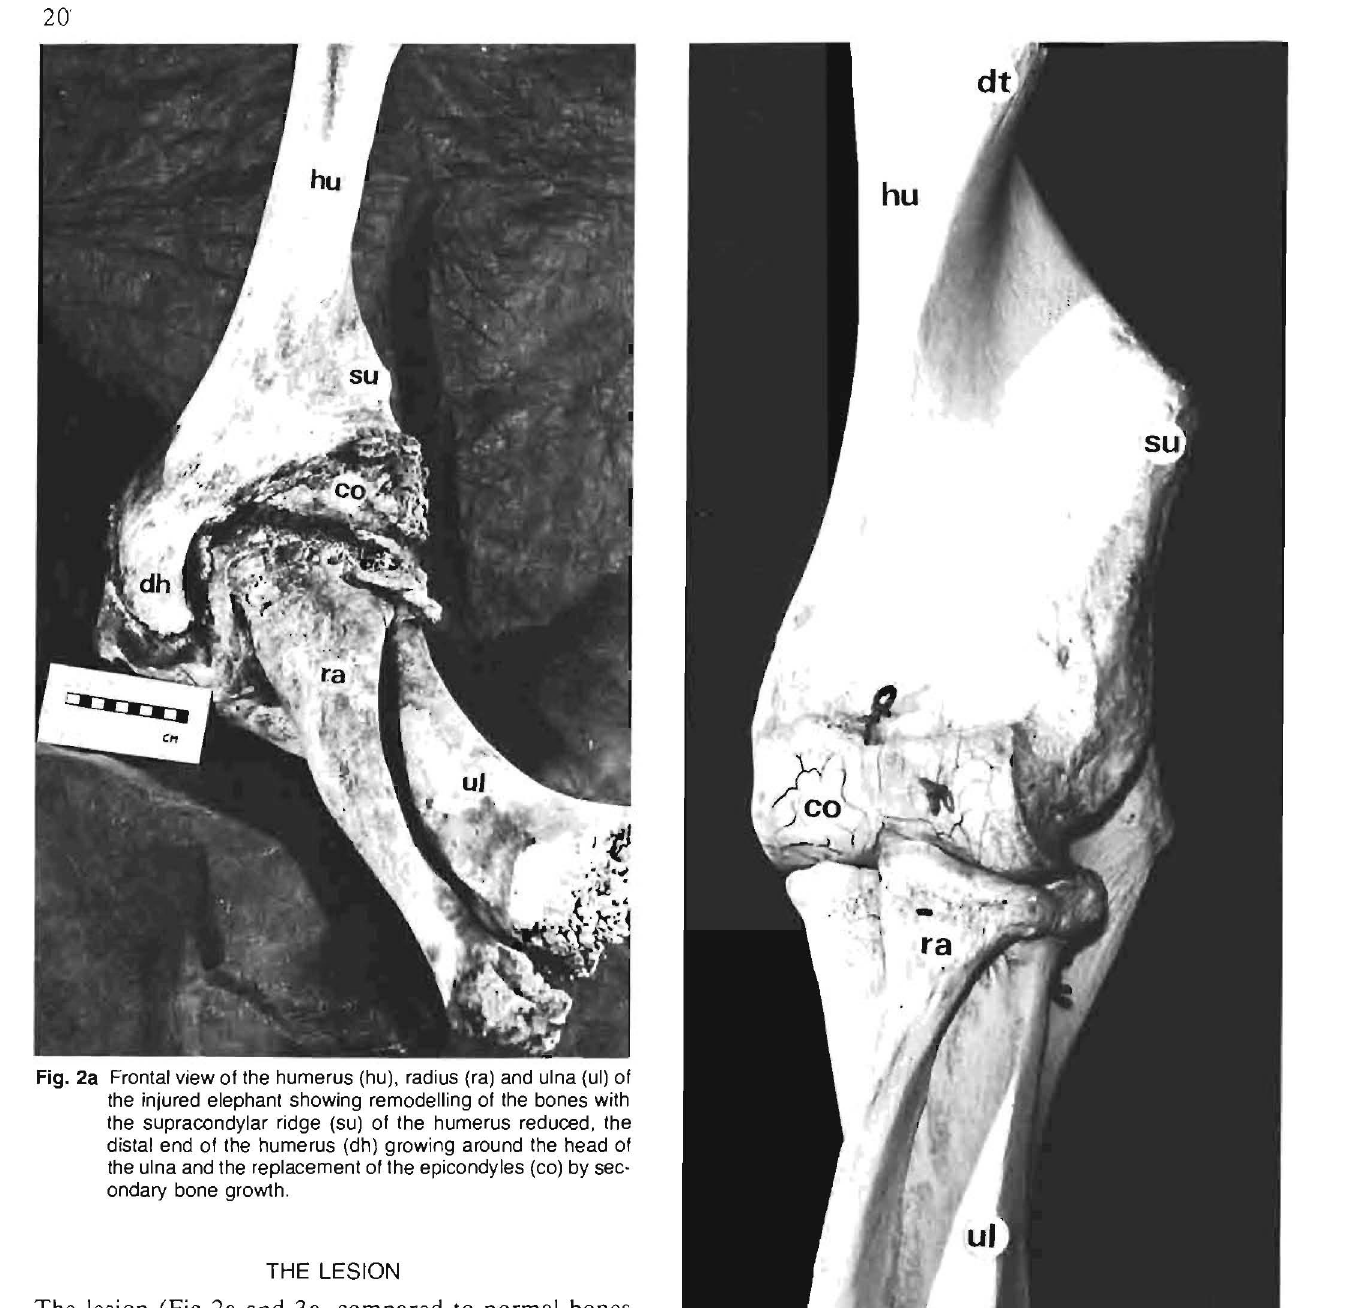
Fig. 2b Frontal view of the elbow joint of a normal elephant showing marked deltoid tuberosity (dt) and supracondylar ridge (su), smooth articulating surfaces of the epicondyles (co). and marked angularities on the surface of all the bones. the ulna. Extensive osteophytic growth had taken place at the edges of the contact area between the